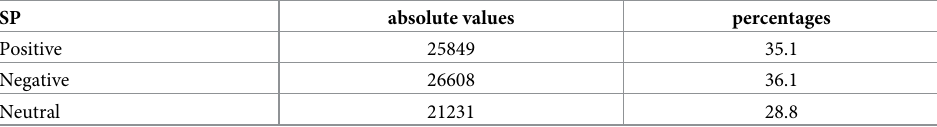
Table 2. Number of tweets for sentiment polarity.